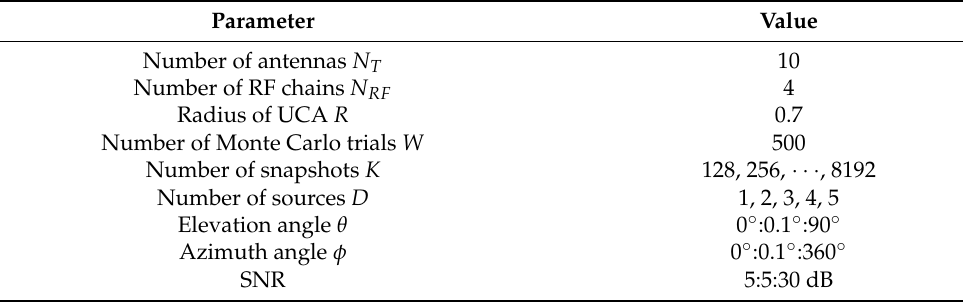
Table 2. Simulation parameters.